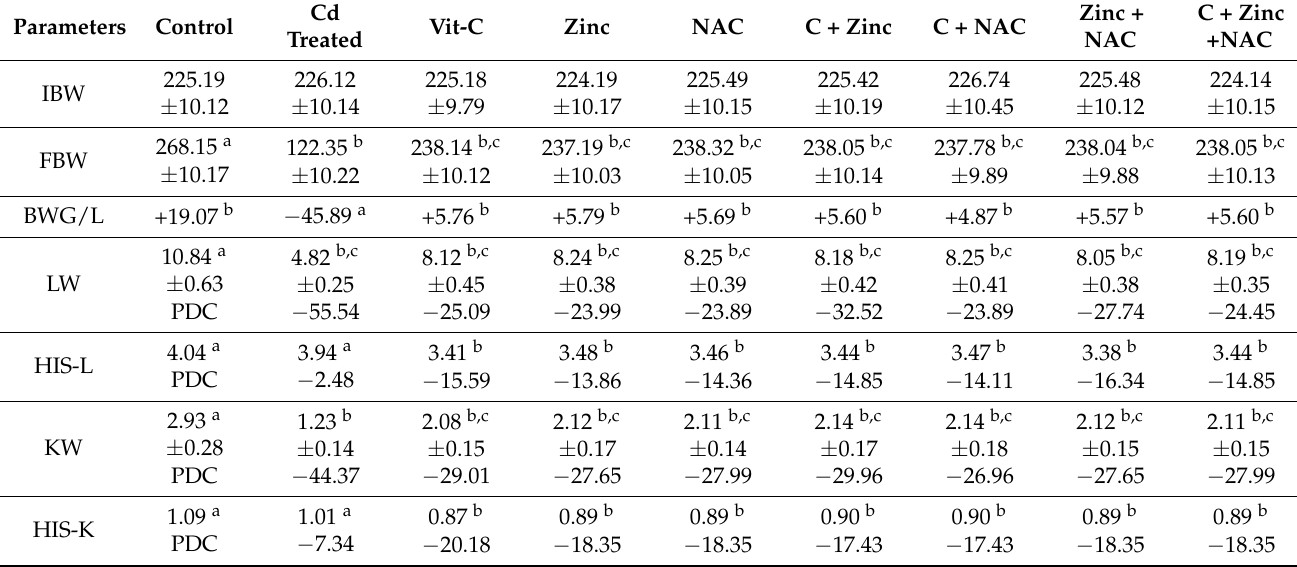
Table 1. Body and relative organ weight in control and experimental